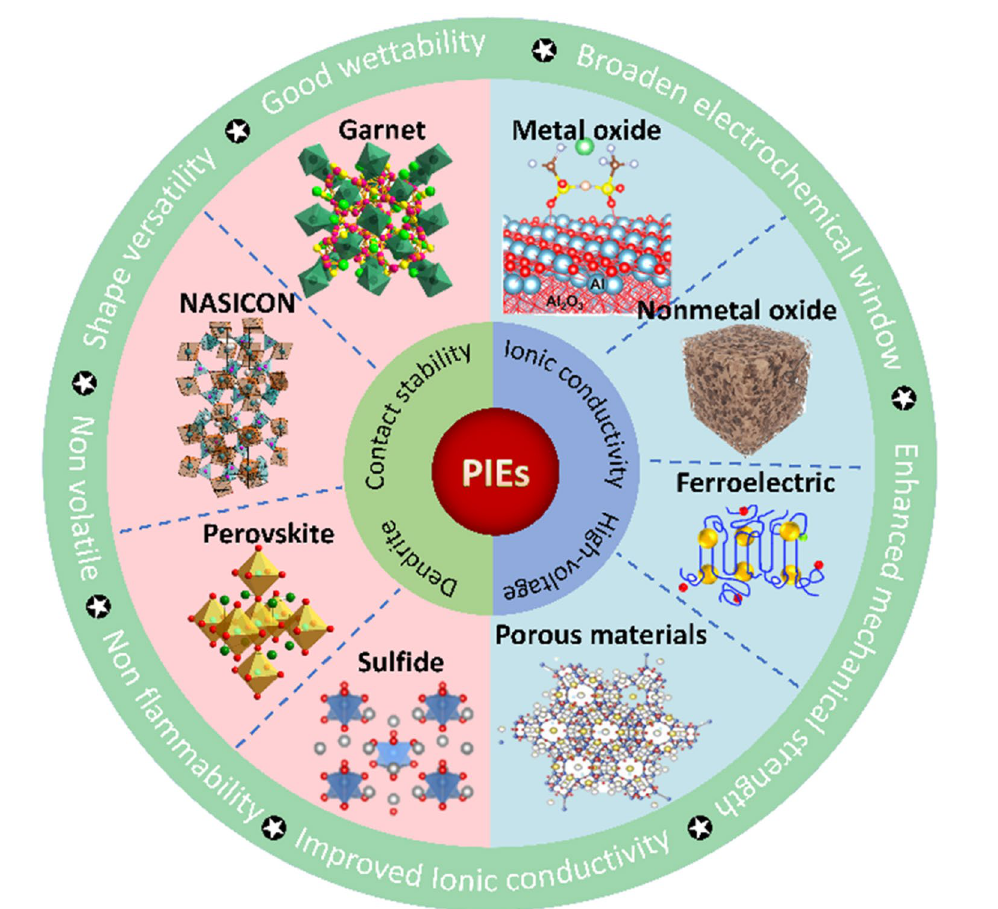
Fig. 14 Overview of the topics in this